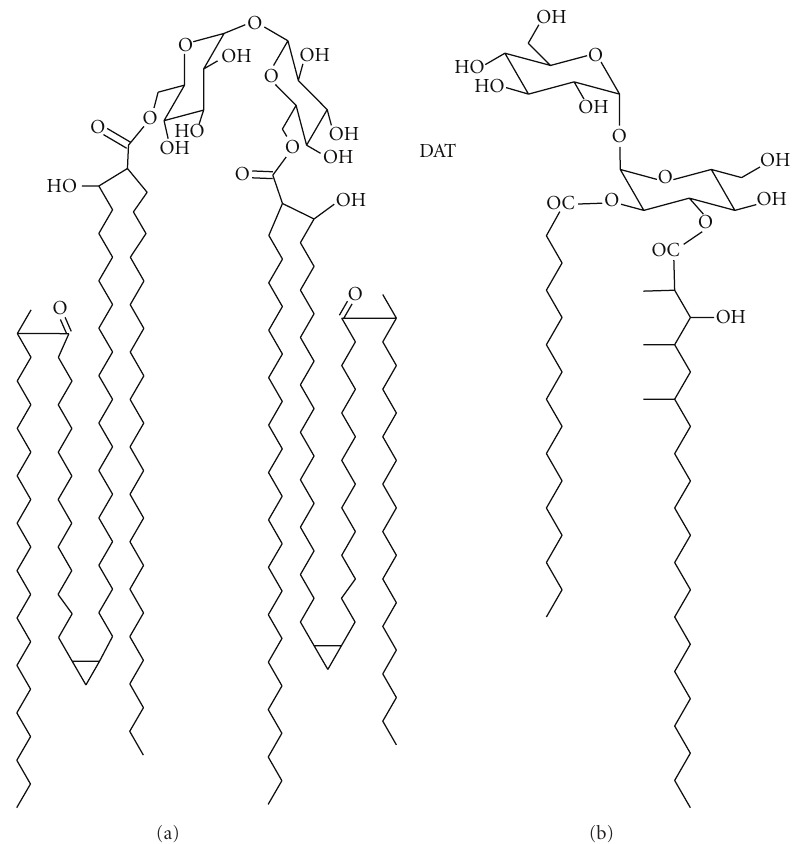
Figure 2: Acylated trehaloses of M. tuberculosis cell walls. Acylated variants of alpha,alpha (cid:2) -(1 → 1 (cid:2) )-glucosyl glucose (trehalose) are abundant in mycobacterial envelopes. These are free amphipathic lipids known to display paradoxical immune modulatory activities. For instance, trehalose 6,6 (cid:2) -dimycolate (TDM) presents potent proinflammatory and granulomatogenic properties [24, 25], whereas 2,3-di- O - acyl trehalose (DAT) exhibits down-modulatory e ff ects on immune cells [26,